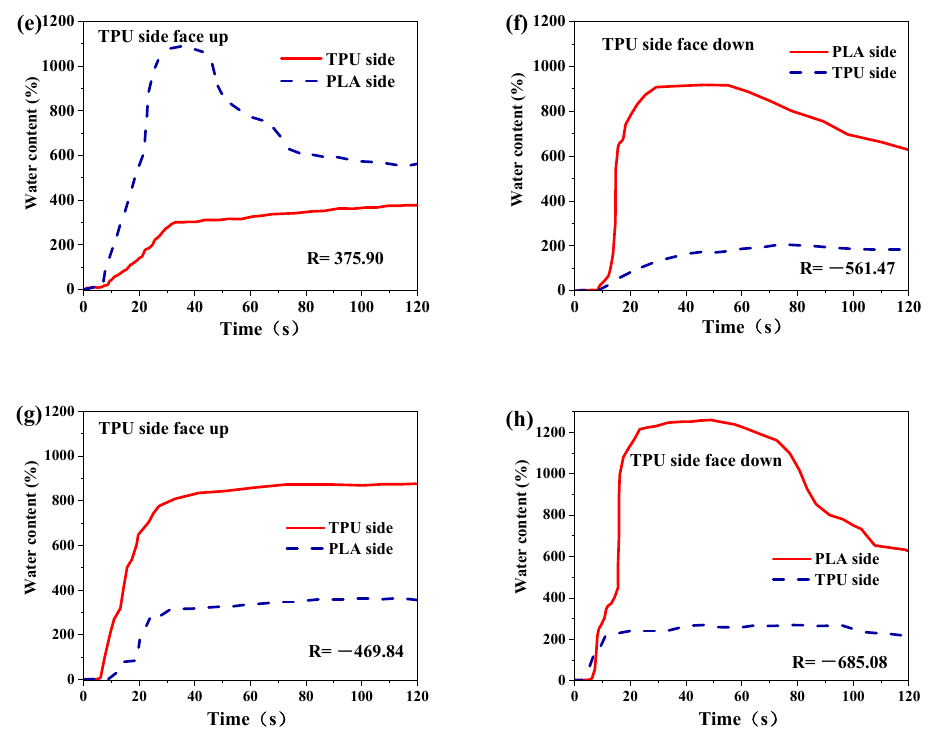
Figure 8. MMT results on composite membranes under different TPU thicknesses: ( a , b ) 8 µ m, ( c , d ) 16 µ m, ( e , f ) 32 µ m, ( g , h ) 64 µ m. The water was dropped onto the different sides.